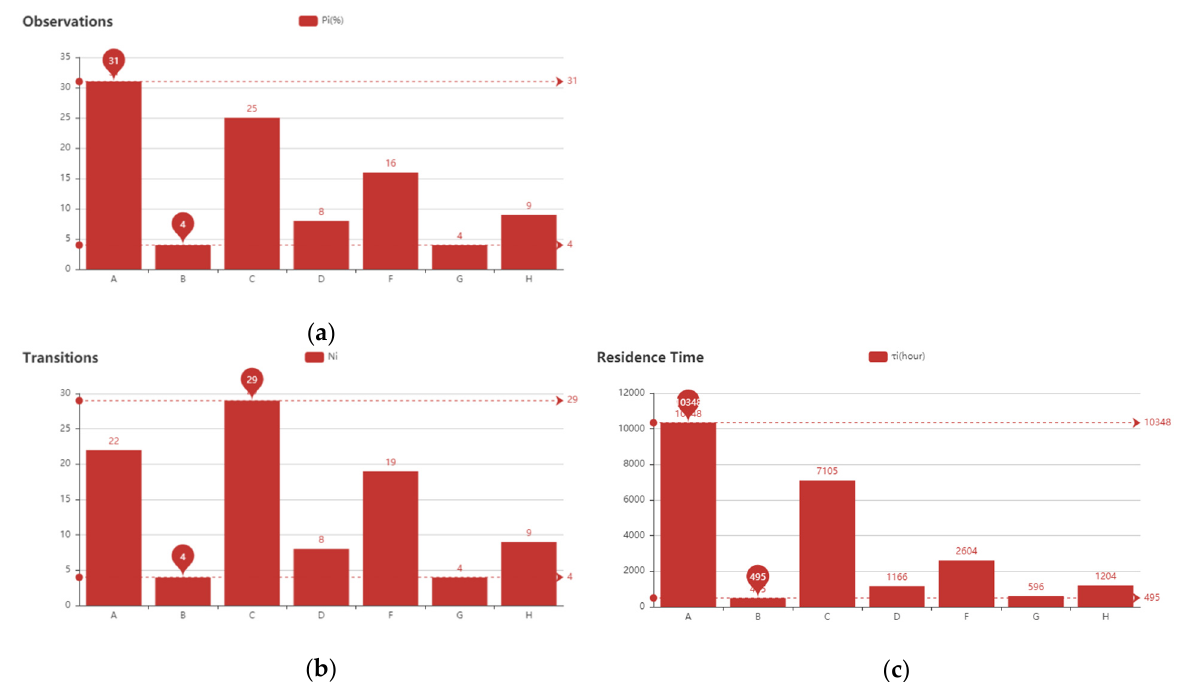
Figure 6. Three statistical indicators of all beach types. ( a ) Occurrence percent of beach type (%) Pi, which is computed by the number of days of one bar type observed dividing the total number of sample days. ( b ) Transition of beach type (%) Ni, which is calculated by the number of one beach state transforming to other states dividing the total number of transitions. ( c ) Residence time of bar type (hours) τ i.